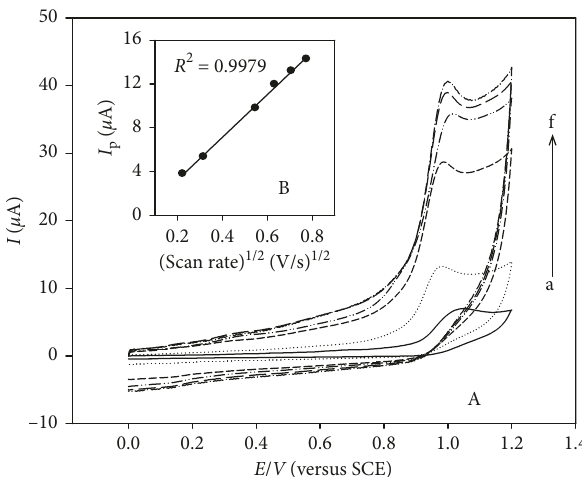
3 M adenine on the glassy carbon elec- 10 × −